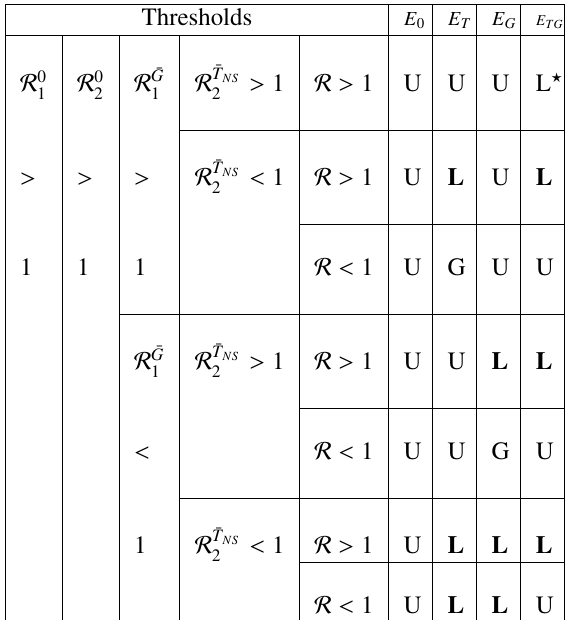
S ummary table of the qualitative analysis of system